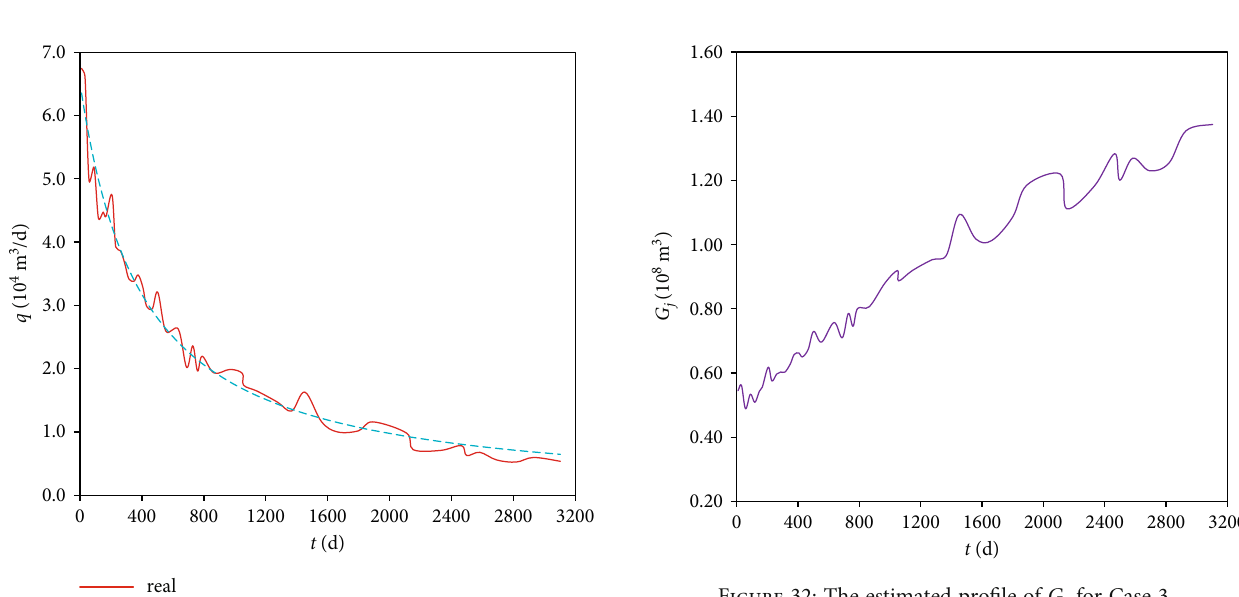
Figure 29: The estimated pro fi le of G